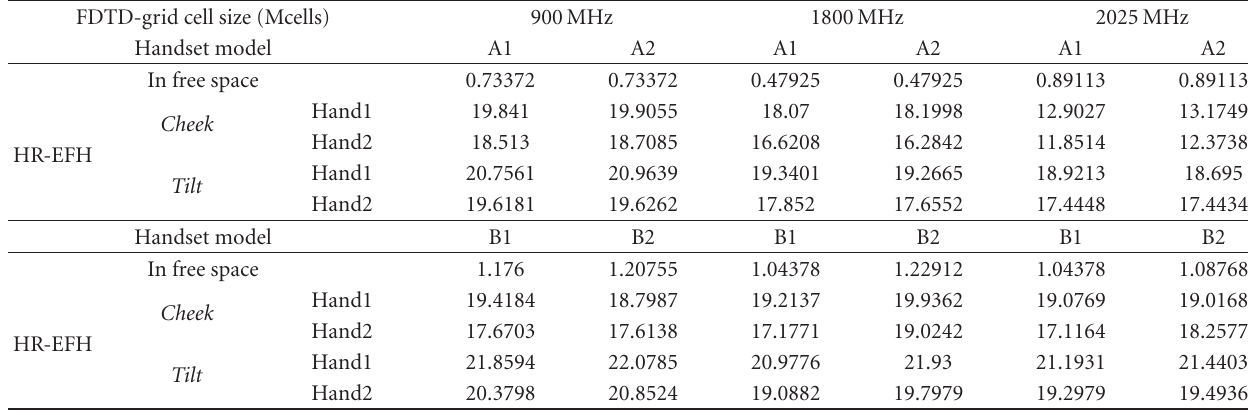
Table 3: The generated FDTD grid cell size of the studied handset models in free space and in hand close to HR-EFH at di ff erent positions operating at 900, 1800, and 2025MHz.